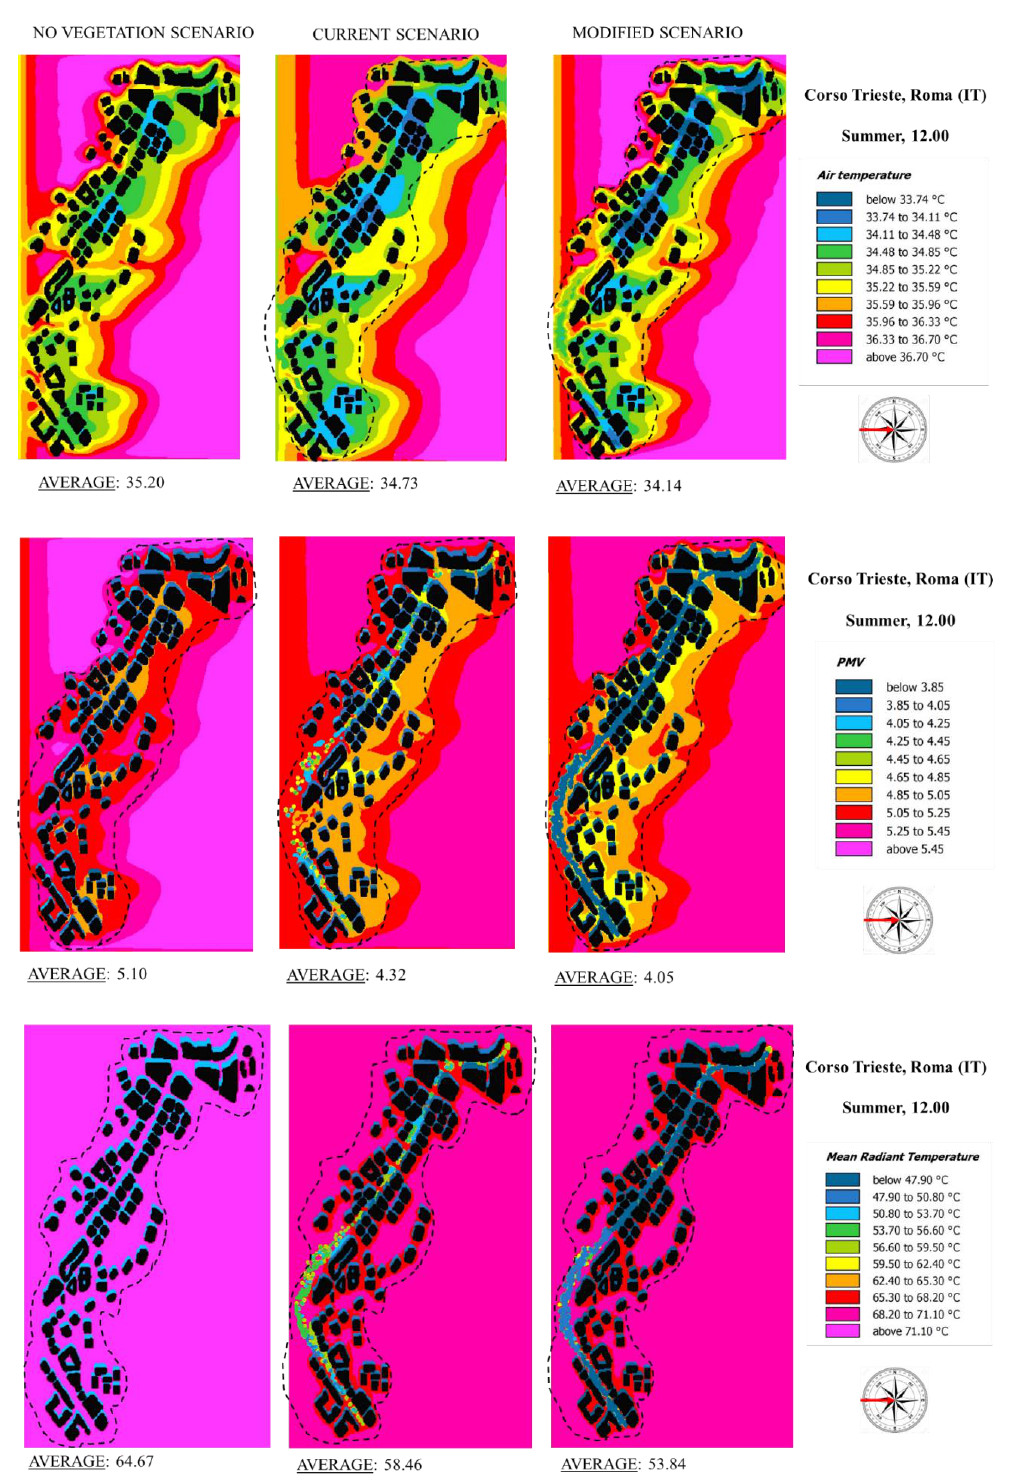
from buildings. Values of microclimate variables at pedestrian height (1.4 m) are shown in Figure 12. In addition, the averages over the area are also computed.